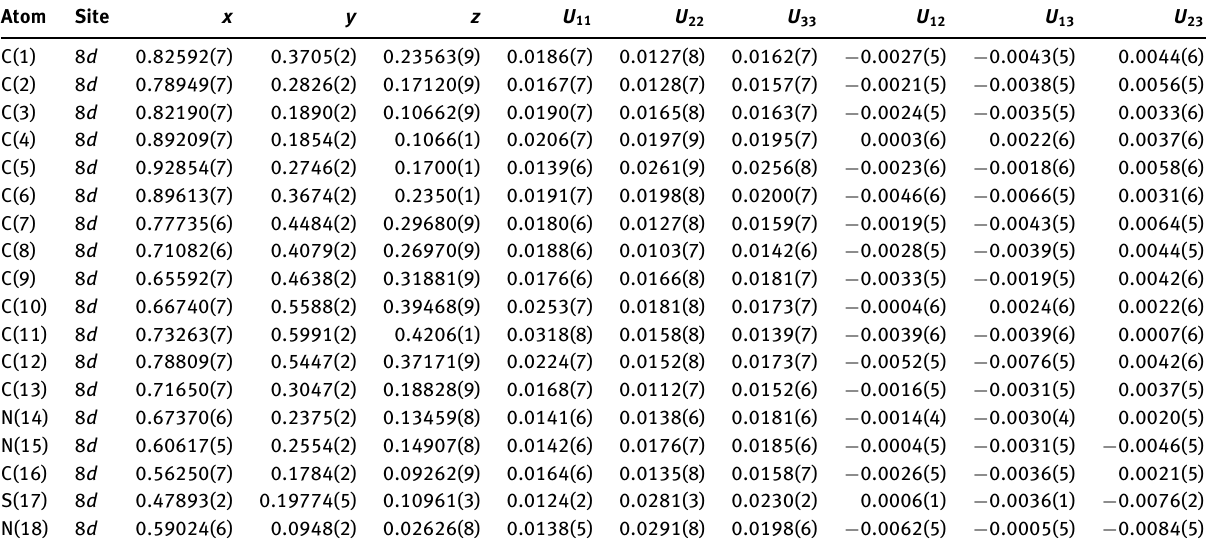
Table 3: Atomic displacement parameters (Å 2